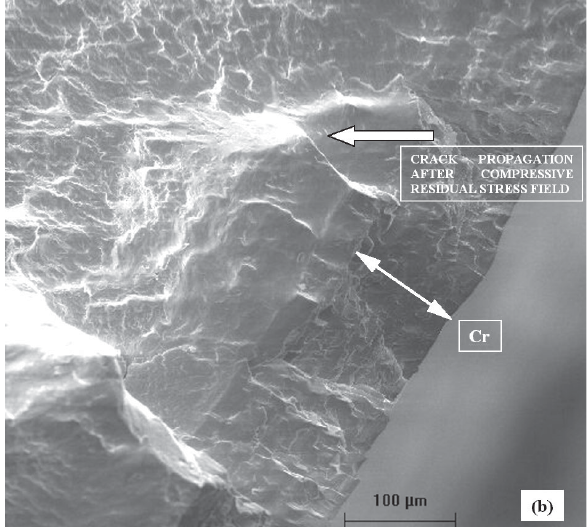
Figure 6b. Fracture surface of accelerated hard chromium elec- troplated specimen, 100 µ m thick, submitted to shot peening pre